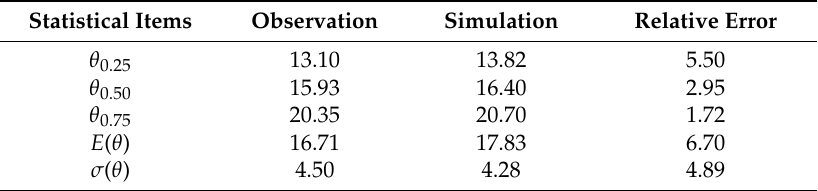
Table 8. Statistical characteristics of soil moisture θ in validation period (Unit: %).